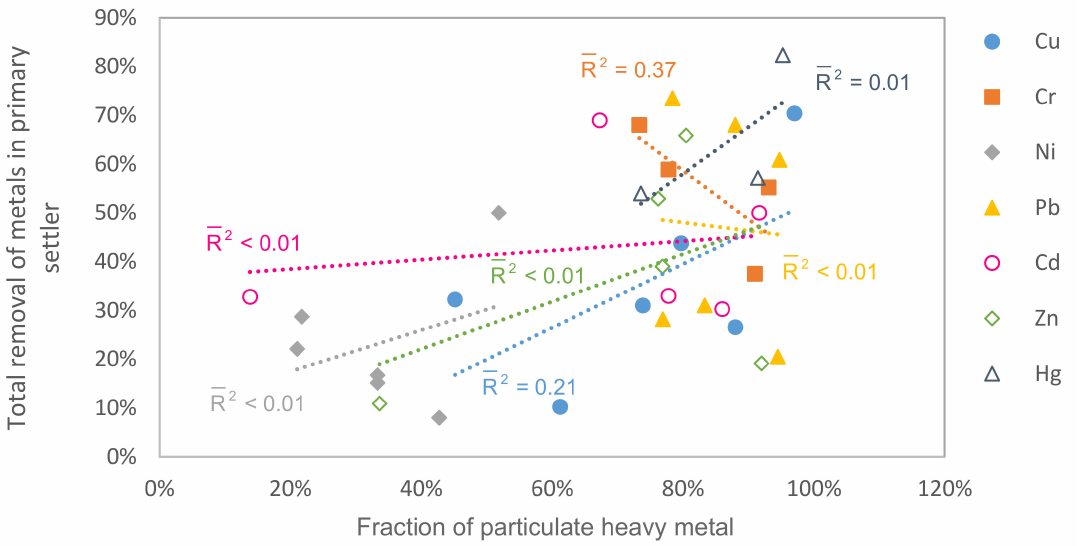
Figure 2. Total removal of heavy metals in primary settler at different fractions of particulate heavy metals in raw wastewater. [35,39,41–44,47,48]. (Data for As and Ag not available.) The dotted lines represent the linear regression between the fraction of particulate heavy metals in raw wastewater and total removal of heavy metals in the primary settler, and strength of correlation is indicated with R 2